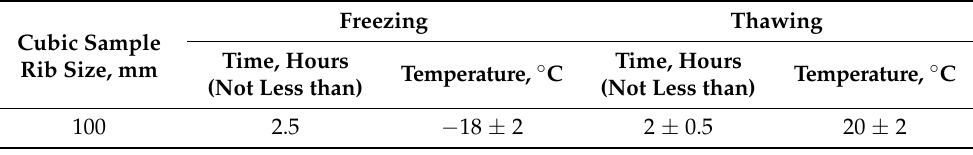
Table 10. Test conditions for determining the frost resistance [16].